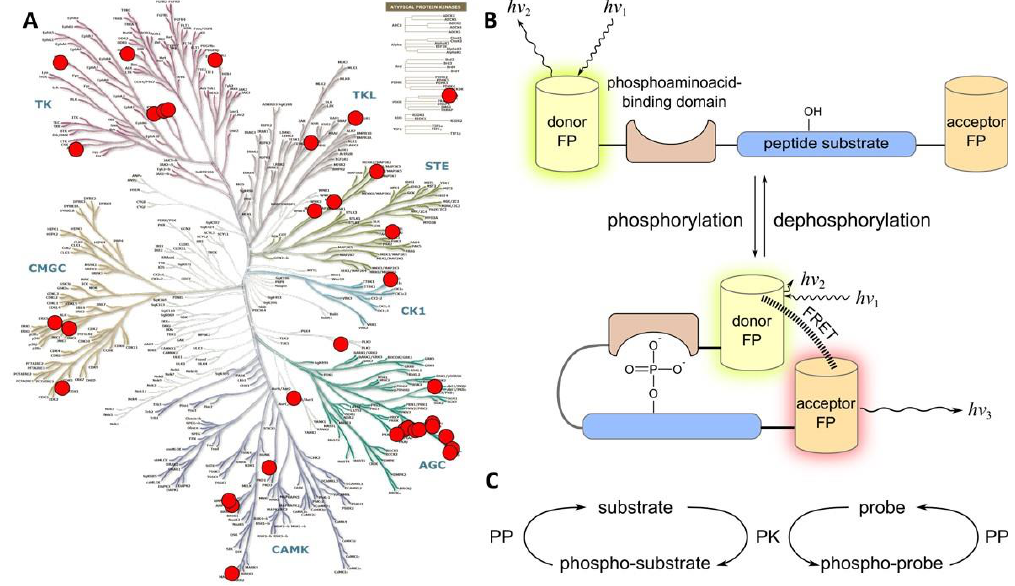
Figure 3. Class 1A probes. ( A ) Human PKs for which Class 1A probes (red circles) have been reported (kinome tree adapted from [104], illustration generated by analog of software available at [105]). ( B ) Principle of functioning of a Class 1A probe containing PAAD (adapted from [96]). ( C ) Probe competes with the endogenous substrate for phosphorylation. PK, protein kinase; PP, protein phosphatase.